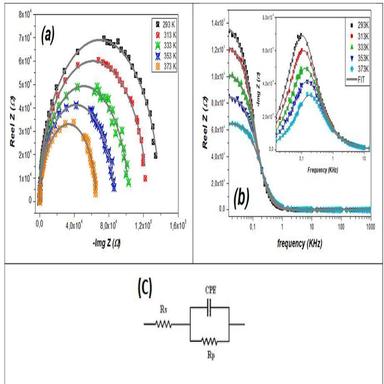
cole-cole plots (a) and frequency dependence of Z′ and Z″, (b) at different temperatures, and (c) Complex impedance plots of device, at different temperatures.